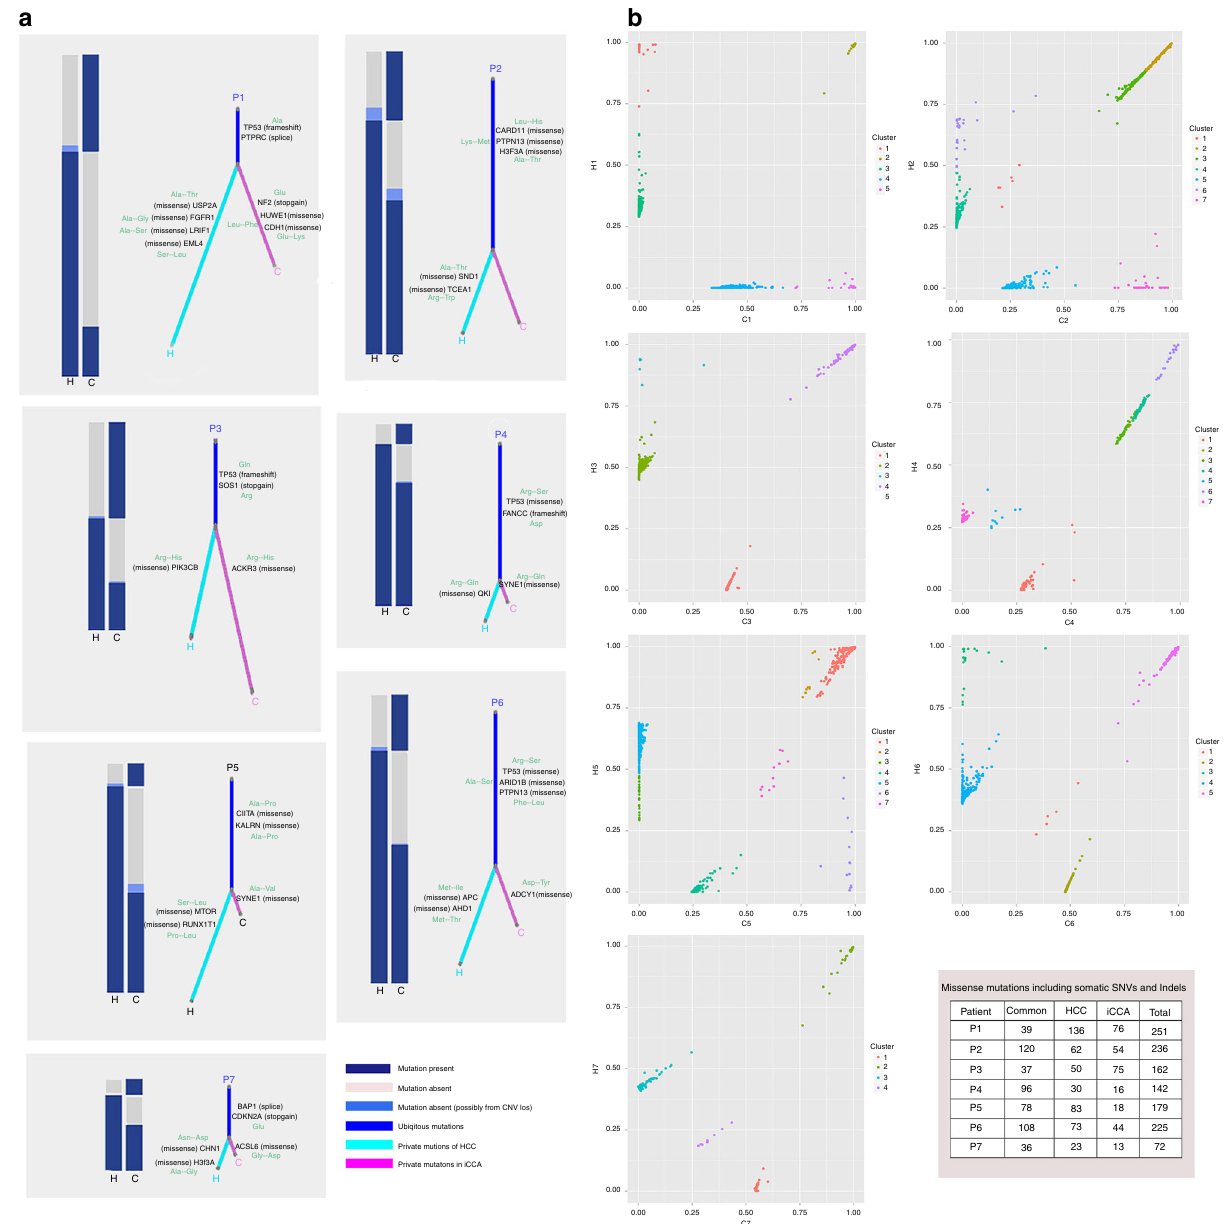
Fig. 5 Missense mutations and cancer cell fraction comparisons within each H-ChC. a Heatplot with different bars represents various distributions of missense mutations including somatic SNVs and Indels within H-ChC. Fraction of ubiquitous nonsynonymous somatic mutations (trunk) (blue bar) and unique nonsynonymous somatic mutations (branch) (green bar for HCC and pink bar for iCCA) reveal the relationship of two tumor samples within a single H-ChC. Part of driver mutations was marked on trunk and branch of evolutionary trees. b Two-dimensional scatter plots show the cancer cell fraction (CCF) of the mutations in HCC and iCCA components of tumors. Different clusters were calculated from each H-ChC sample. Clusters off the axes indicate mutations in both of tumor components. Clusters on the axes reveal mutations in either HCC or iCCA components. c The table shows missense mutations in different tumor